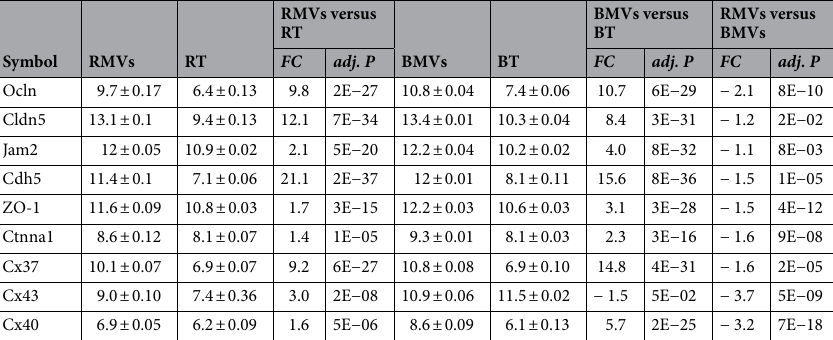
Table 2. List of intercellular junction genes differentially expressed in rat retina and/or brain microvessels vs. retina and brain tissue samples. Results are mean ± SEM of log 2 transformed microarray intensity values (n = 6). RMVs, retinal microvessels; RT, retinal tissue; BMVs, brain microvessels; BT, brain tissue; FC , fold change; adj. P , false discovery rate adjusted p value; Ocln, occluding; Cldn5, claudin 5; Jam2, junctional adhesion molecule 2; Cdh5, VE-cadherin; ZO-1, zonula occludens protein 1; Ctnna1, catenin α1; Cx,